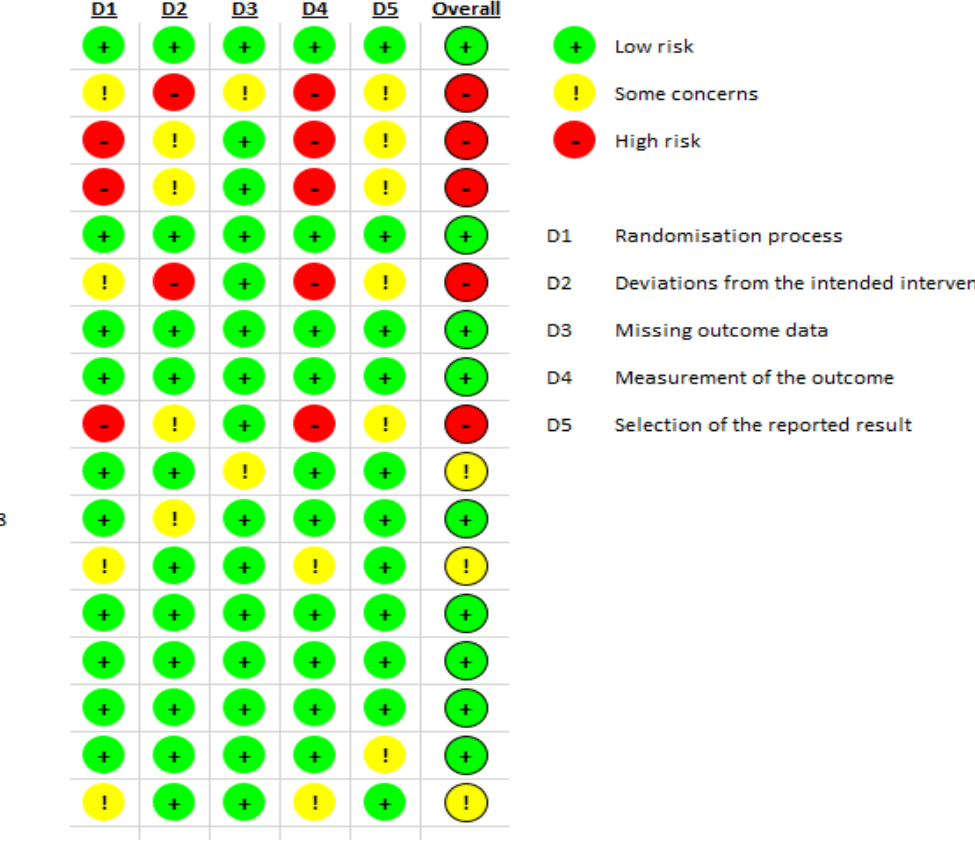
Figure 2. Assessment of the risk of bias (Robins ‐ 2 Beta version, Cochrane) .